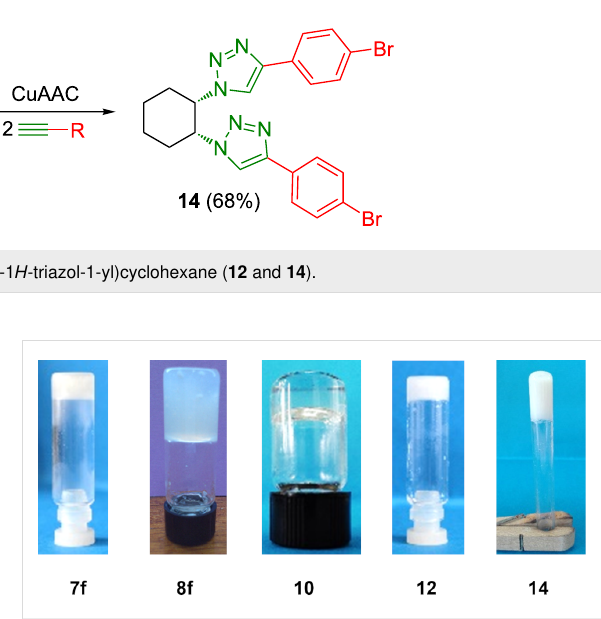
was critically dependent on the cis / trans configuration present in the